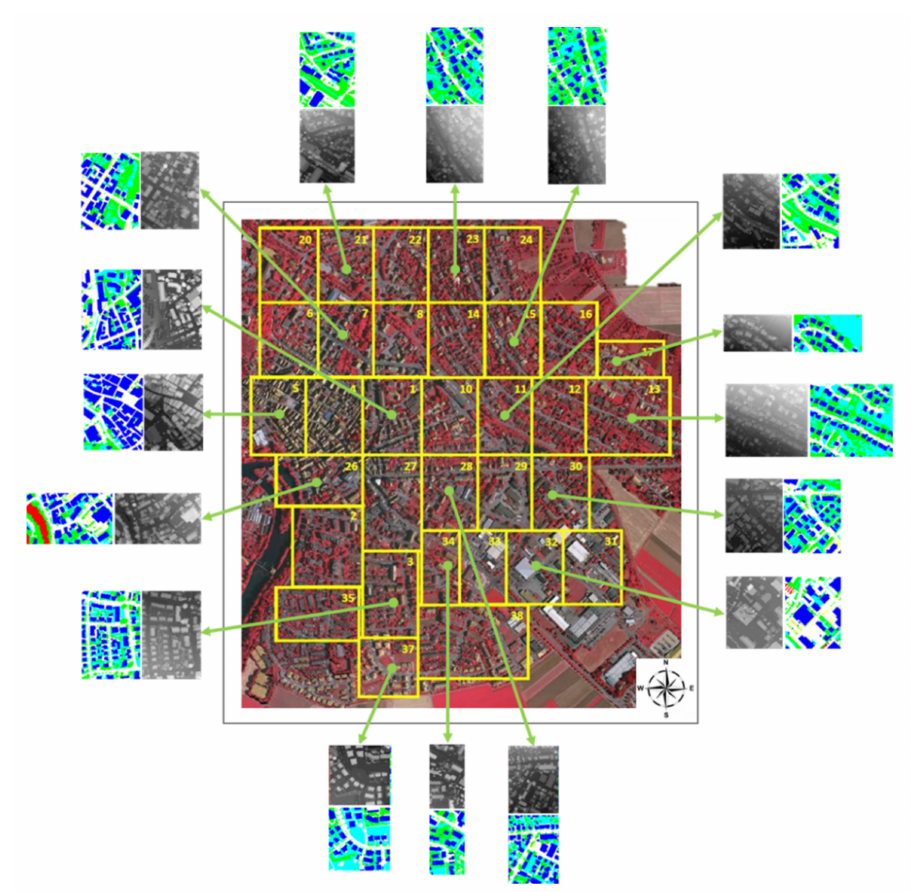
Figure 6. ISRPS Vaihingen datasets for 2D semantic labeling overlaid on IR